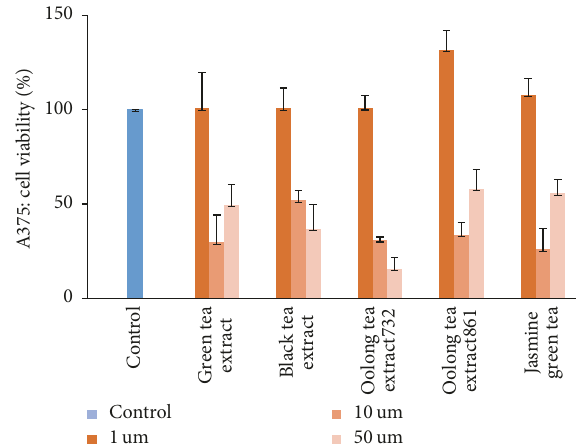
Figure 2: Effects of five extracts on cell viability of normal human cell and malignant melanoma cell according to MTT assay. Per- centage of cell viability was measured in A2058 cultured with 1 𝜇 m, 10 𝜇 m, and 50 𝜇 m.